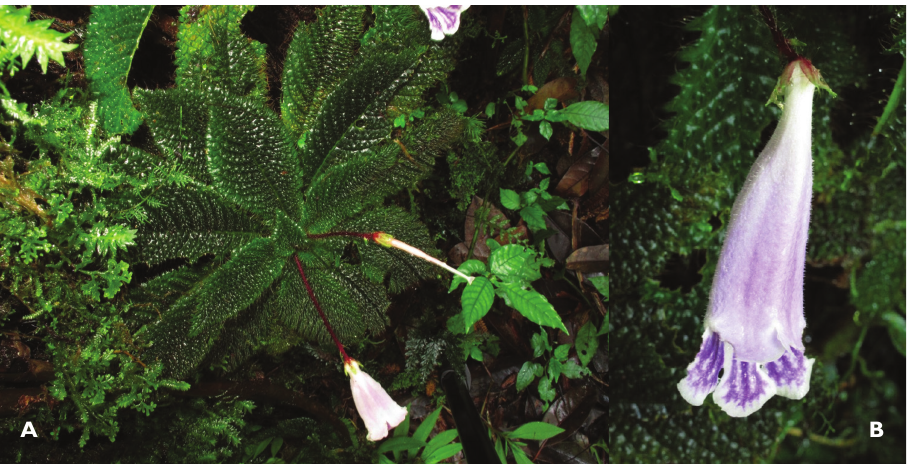
A Figure 1. Ridleyandra chuana Kiew . A habit B flower.